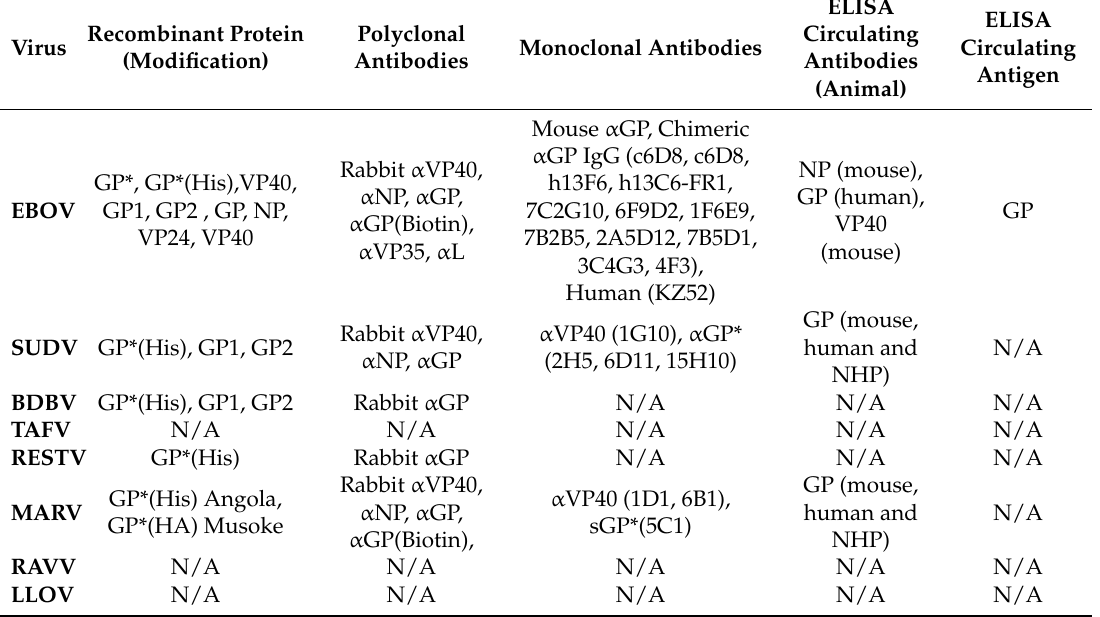
Table 7. Reagents commercially available for filovirus studies. * = GP1,2 without transmembrane domain. N/A, not available. Updated as of 9 September 2015. Recombinant Protein Virus (Modification)